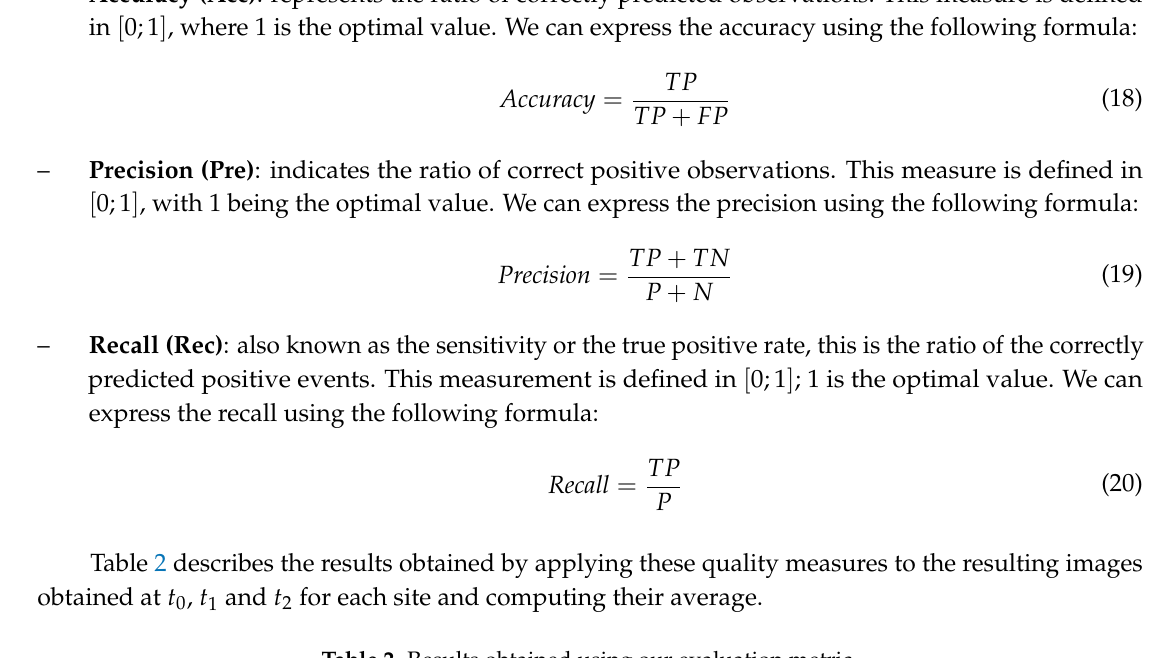
Table 2. Results obtained using our evaluation